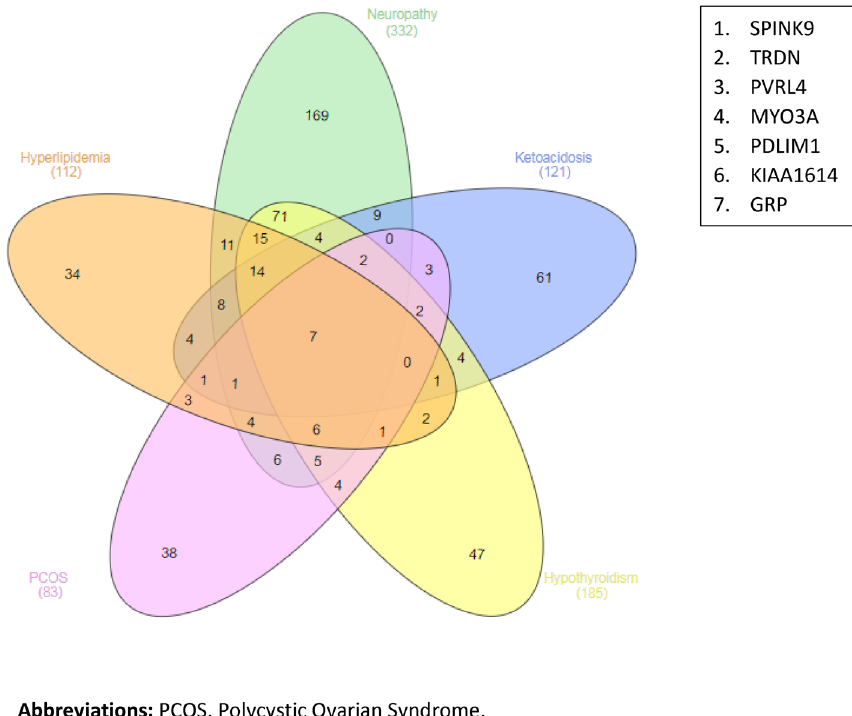
Figure 6. Differentially expressed genes common between all complications. A. Upregulated common genes; B. List of the seven upregulated common genes.